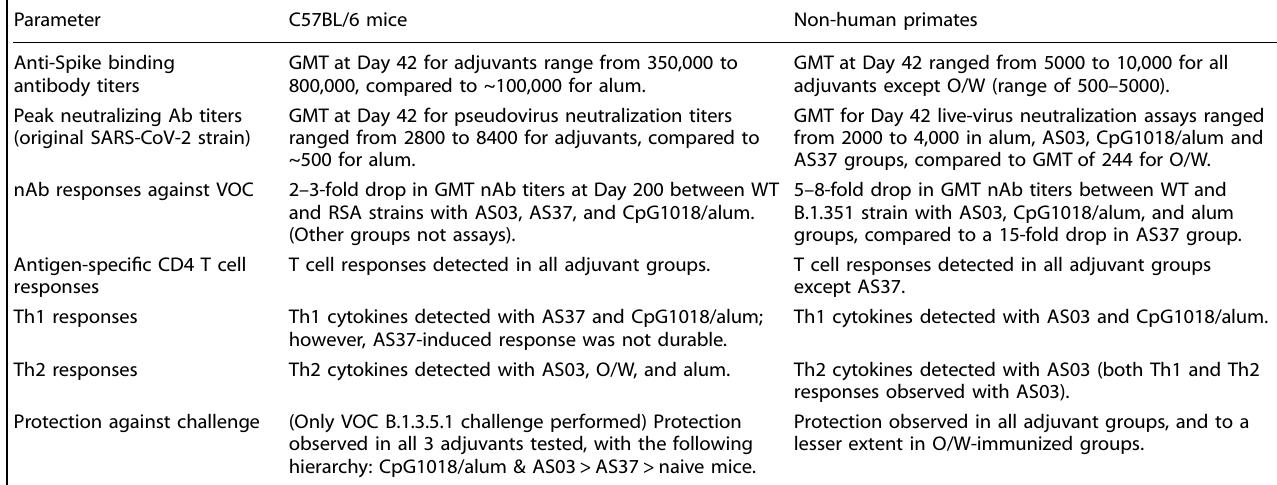
Table 1. Summary of the adjuvant-induced immune responses observed in this mouse study and a parallel NHP study by Arunachalam et al. 3 . Parameter C57BL/6